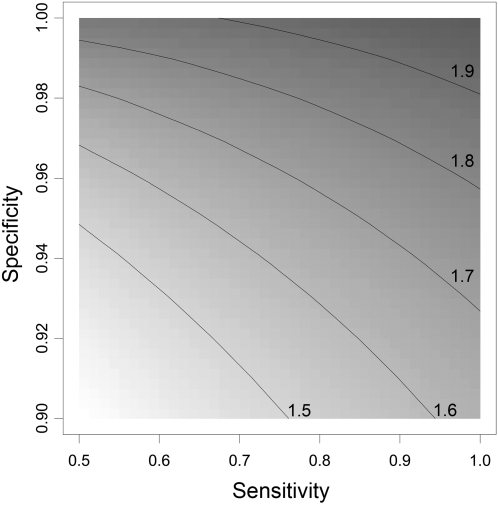
Impact of decreased sensitivity and specificity on a true odds ratio of 2.0 for a specific risk haplotype (fh = 0.2) in a case-control study (500 cases, 500 controls).The shades of grey code for the observed OR with contour lines given for specific observed ORs as derived by the matrix method.